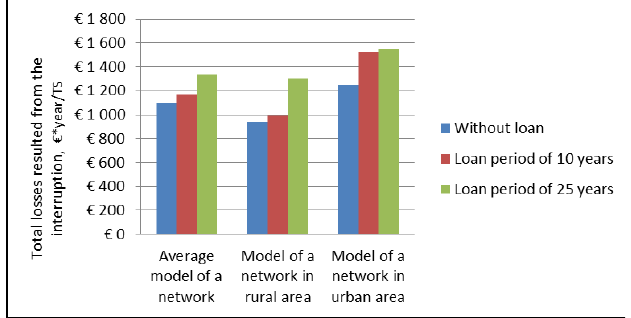
Fig. 8. Total losses resulted from the interruption for the case of power switches optimization.